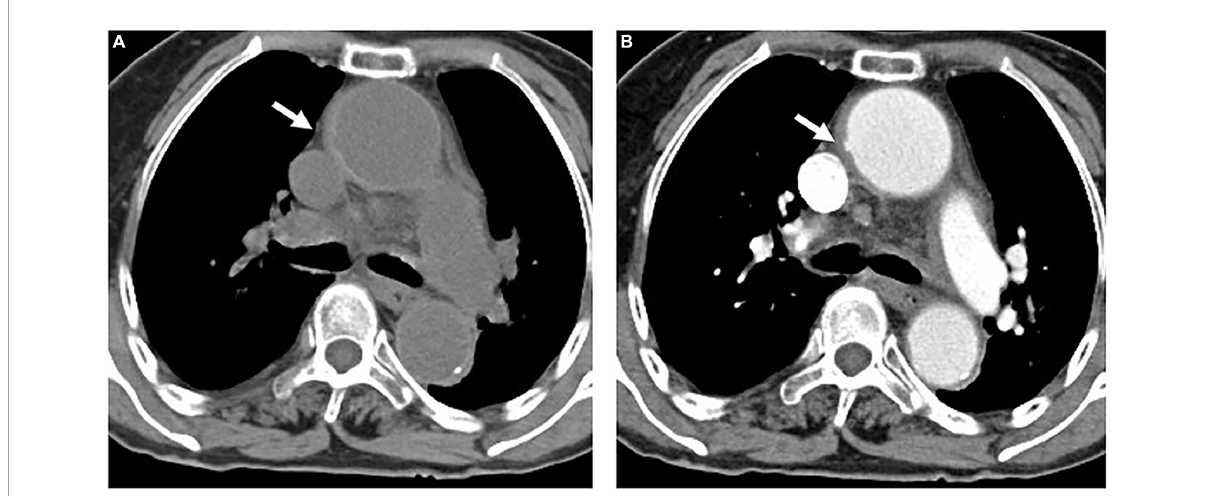
FIGURE1 An 84-year-old woman with TAIMH and tiny ULP. A precontrast CT scan showed circular high attenuation aortic wall thickening (5 mm) (arrow) involving the ascending aorta (49 mm) (A) . A tiny ULP (arrow) was observed in the greater curvature of the ascending aorta (B) . Follow-up CT was not performed and the patient suffered from sudden death on the fourth day of admission. CT, computerized tomography; TAIMH, type A aortic intramural hematoma; ULP, ulcer-like projection.